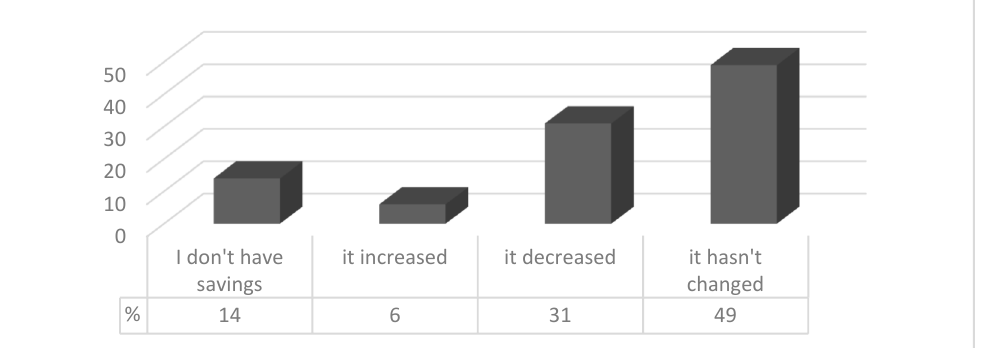
Figure 8. Poles’ savings during COVID-19 pandemic—a survey’s results. Source: (Finanse Polaków w czasie COVID-19 2020, p. 17).